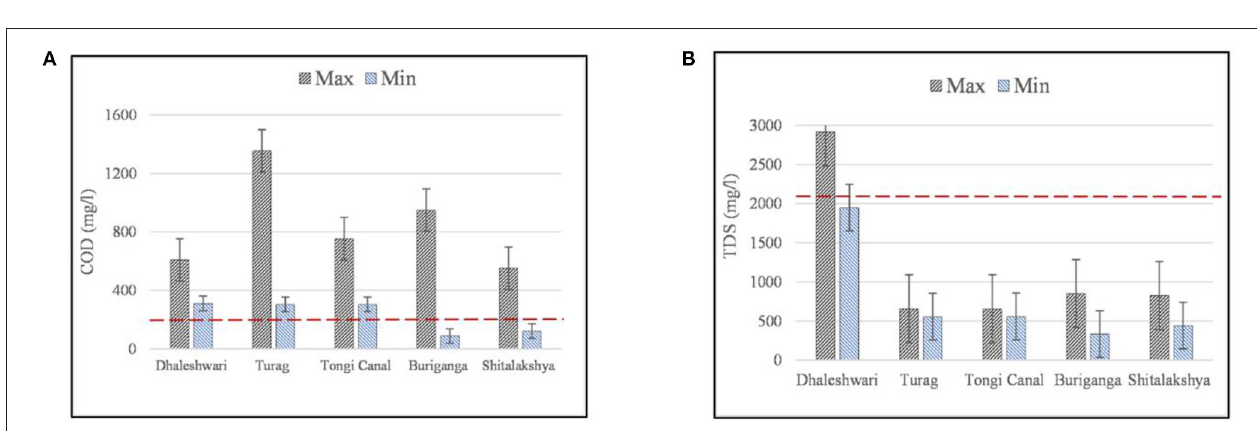
FIGURE 3 | (A,B) Maximum and minimum concentrations of COD and TDS for the selected outfalls along the peripheral rivers of Dhaka (error bars indicate standard error of mean and red dotted lines indicate the Bangladesh standards of water quality according to ECR’97).